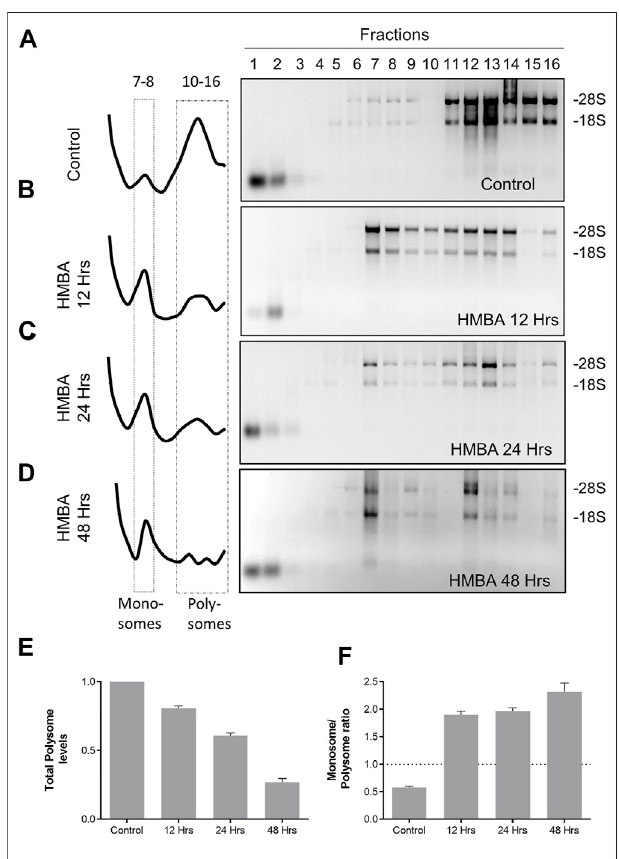
FIGURE 1 | Regulation of ribosome levels during MEL differentiation. (A – D) Analysis of the total RNA material isolated from each fraction of the gradient for the corresponding samples (Control, HMBA 12 h, HMBA 24 h and HMBA 48 h treatment). Each sample was electrophorized in a 2% agarose gel, stained with Etbr and visualized under UV light (experiment was repeated at least 3 times). The left panel corresponds to the A260 pro fi le of each gradient. (E) Alterations in the total polysome levels. Each bar corresponds to the average A260 value of fractions 10 – 16. (F) Monosome/ polysome ratio for each sample. The ratio was calculated by dividing average fractions 5 – 6/average fractions 10 –